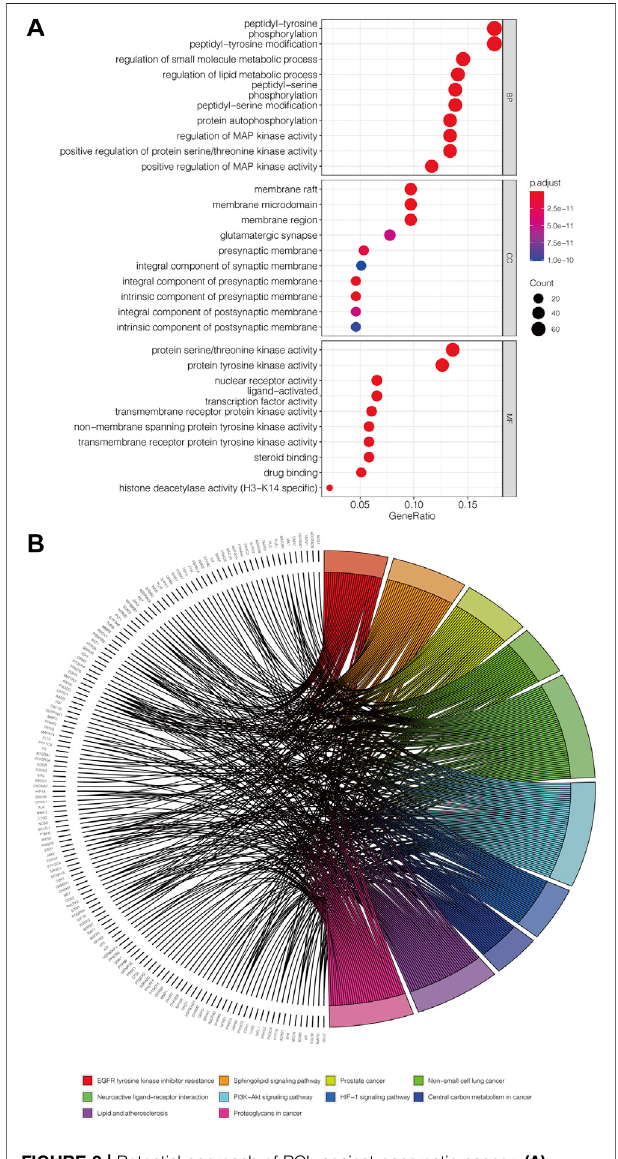
FIGURE 3 | Potential approach of PCL against pancreatic cancer. (A) Secondary classi fi cation dot plot of GO functional enrichment analysis including biological process (BP), cellular components (CC), and molecular function(MF).TheabscissashowstheGOterm, andtheordinateshows the numbers of genes enriched in the GO term. (B) Chord plot of the relationship of the selected gene and their corresponding KEGG terms. The colors display different terms, and the angle of the chord represents the number of genes enriched in the KEGG pathway.